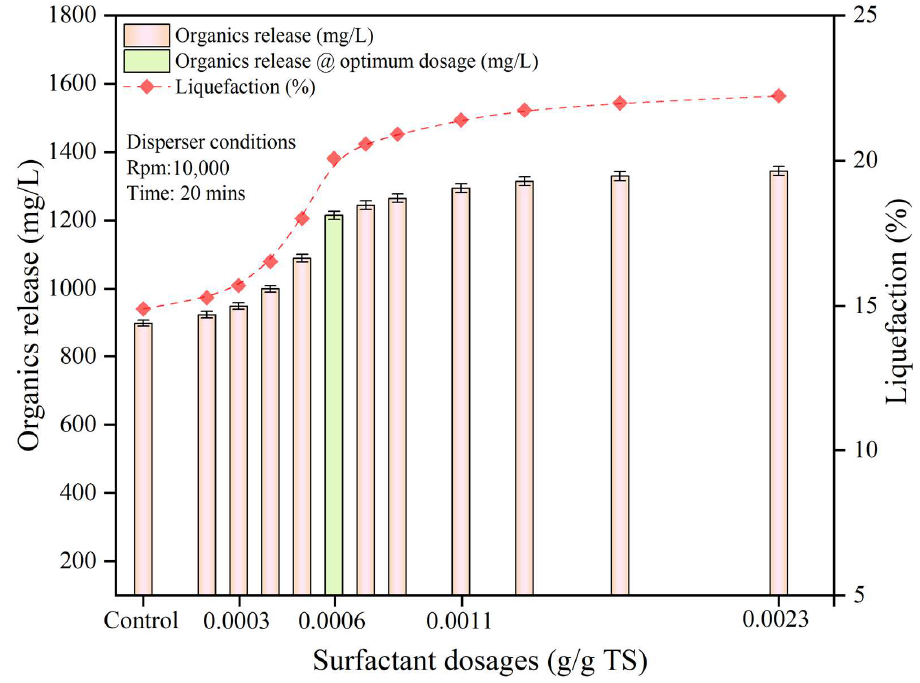
Figure 5. Effect of surfactant dosages on organics release in disperser optimum